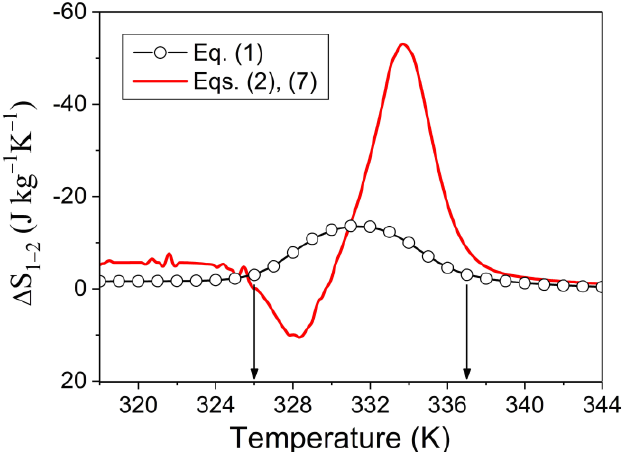
Figure 6. Entropy changes computed from Equation (1) and Equations (2) and (7). The vertical arrows point to the temperatures used for estimation of refrigerant capacity (see Equation (16)).